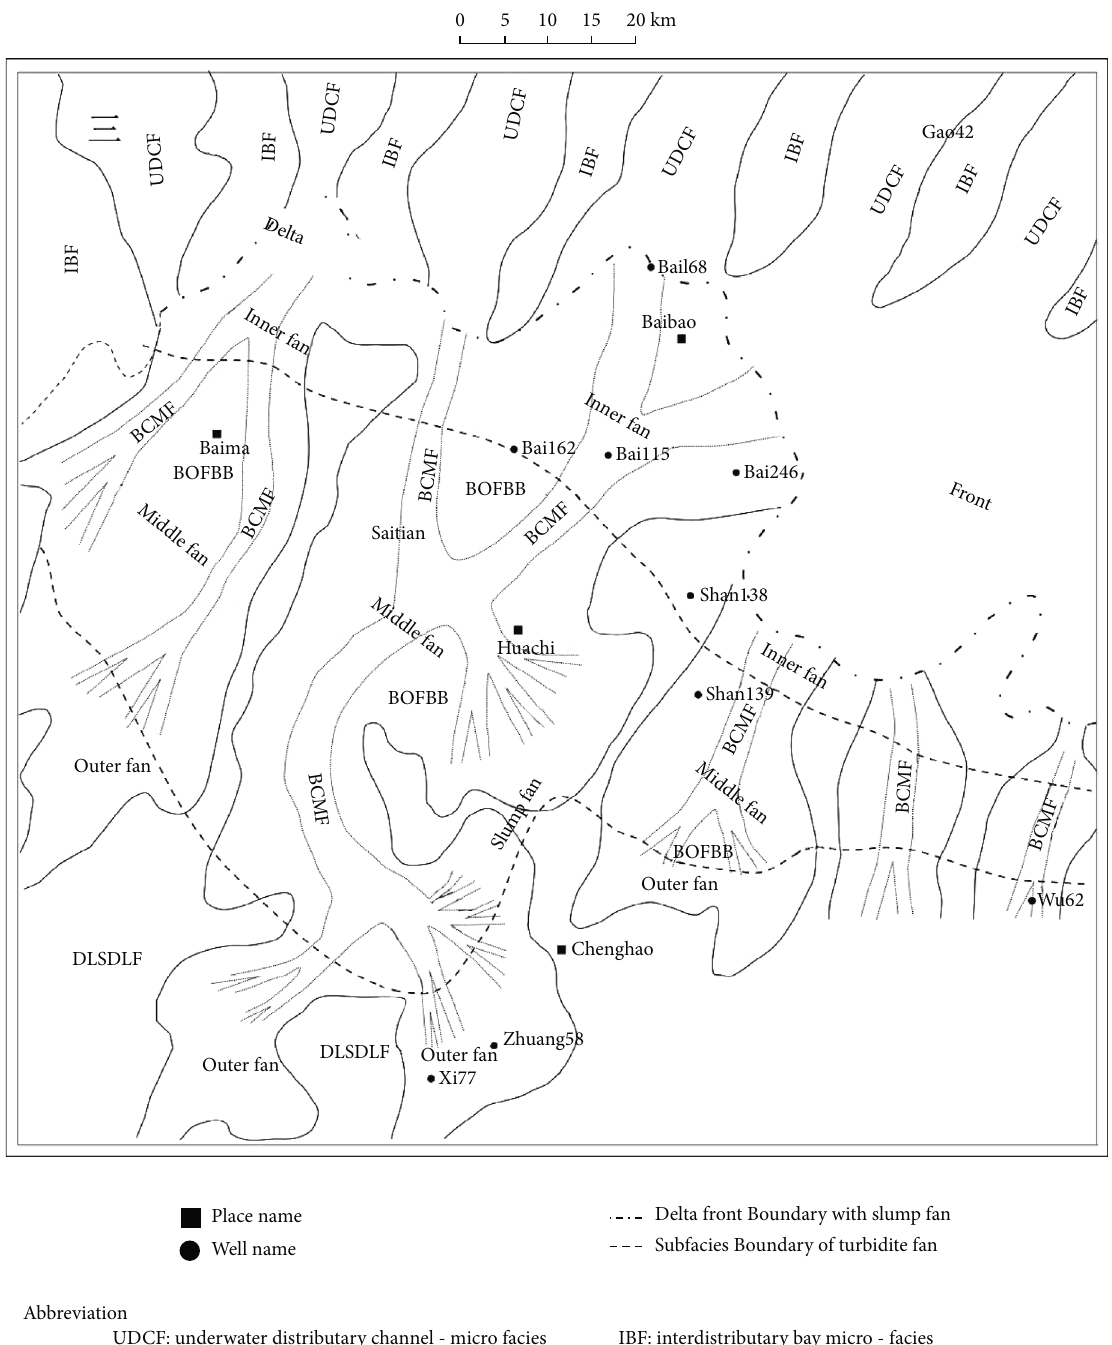
Figure 6: Sedimentary facies distribution map of the Chang 6 3 Member in the Huaqing